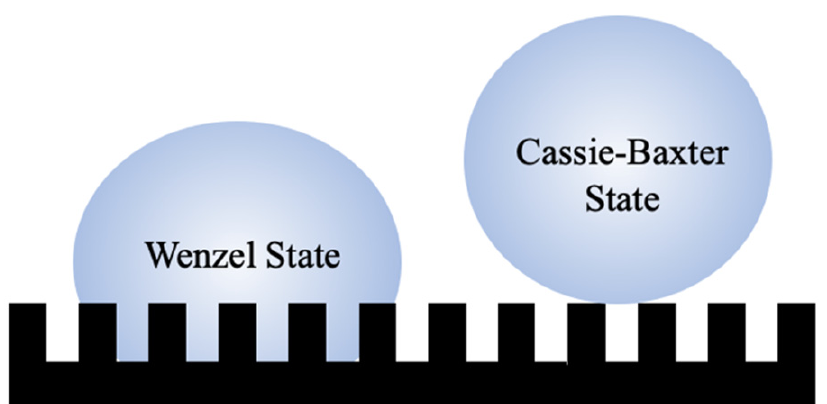
Figure 1. Schematic representation of water droplets suspended on a cuticular surface in the Wenzel state ( left ) and Cassie–Baxter state ( right ). Note: Droplets and texture beneath droplets are not drawn to scale.